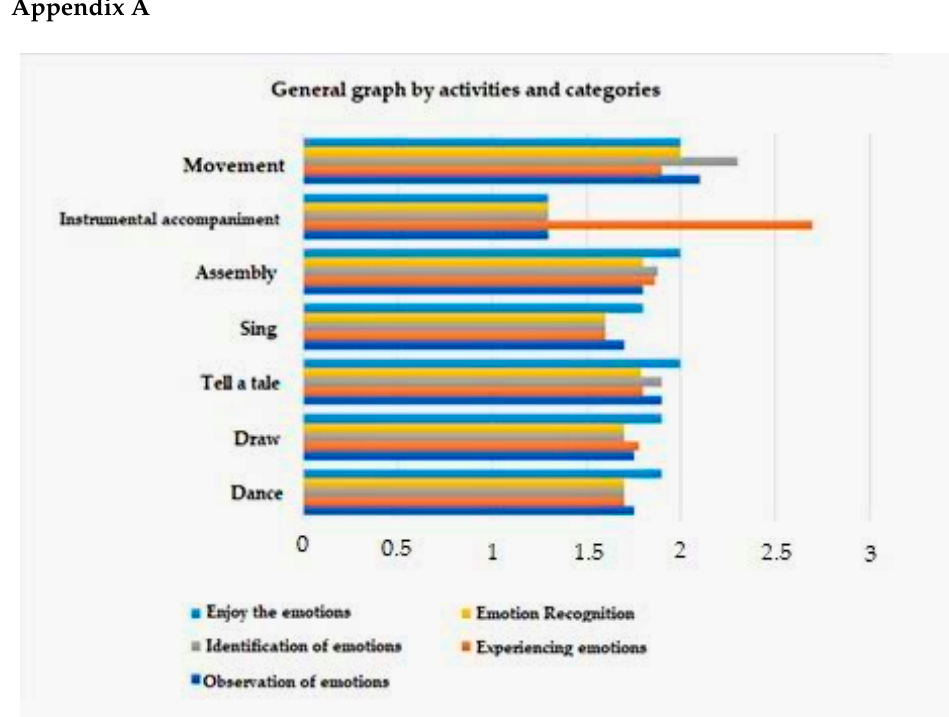
Int. J. Environ. Res. Public Health 2021 , 18 , x FOR PEER REVIEW Figure A1 . General graph by activities and categories. Figure A1. General graph by activities and categories.